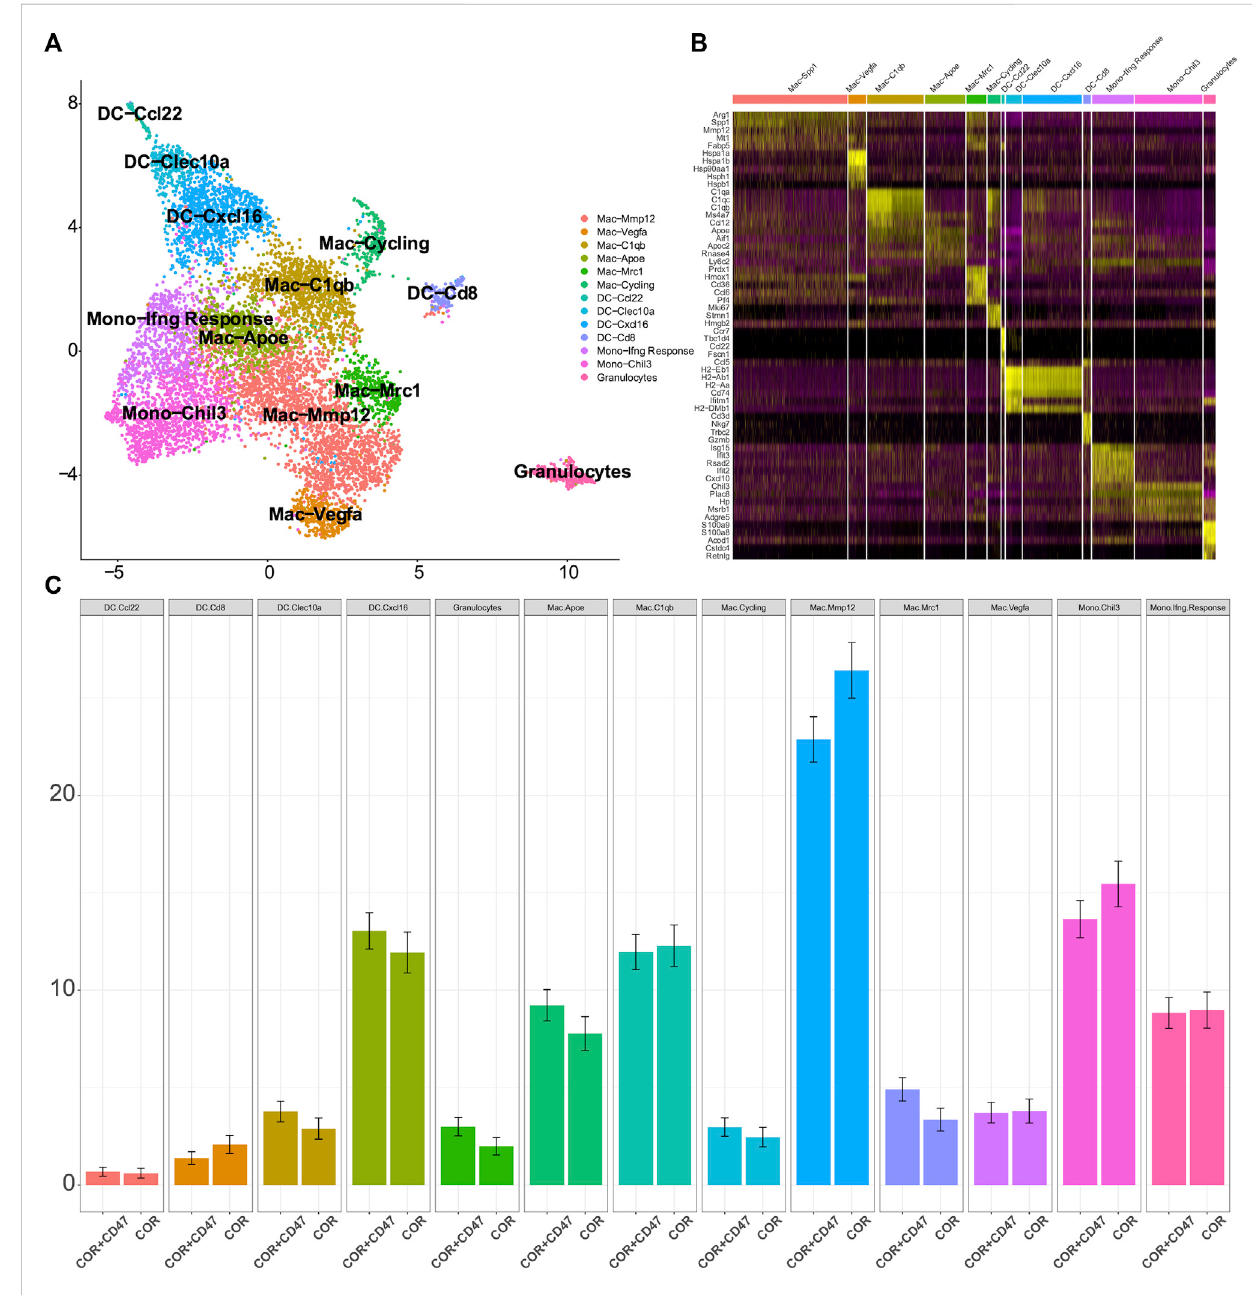
FIGURE 3 scRNA-seqisusedtotestthechangesinmyeloidcells (A) .Sub-clusteringofmyeloidcellsisshownontheUMAPplotsofthescRNA-seqdataset (B) . Individual myeloid cell clusters in the scRNA-seq data could be identi fi ed phenotypically based on a heatmap of myeloid cell lineage and functional markers (C) . MC38 tumors from the combination treatment group or cordycepin group showed the proportions of different subpopulations of myeloid cells. “ COR + CD47 ” represents the combined treatment group; “ COR ” represents the cordycepin treatment